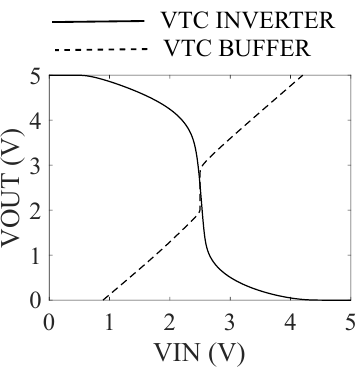
Figure 16. PFGA VTC curves.